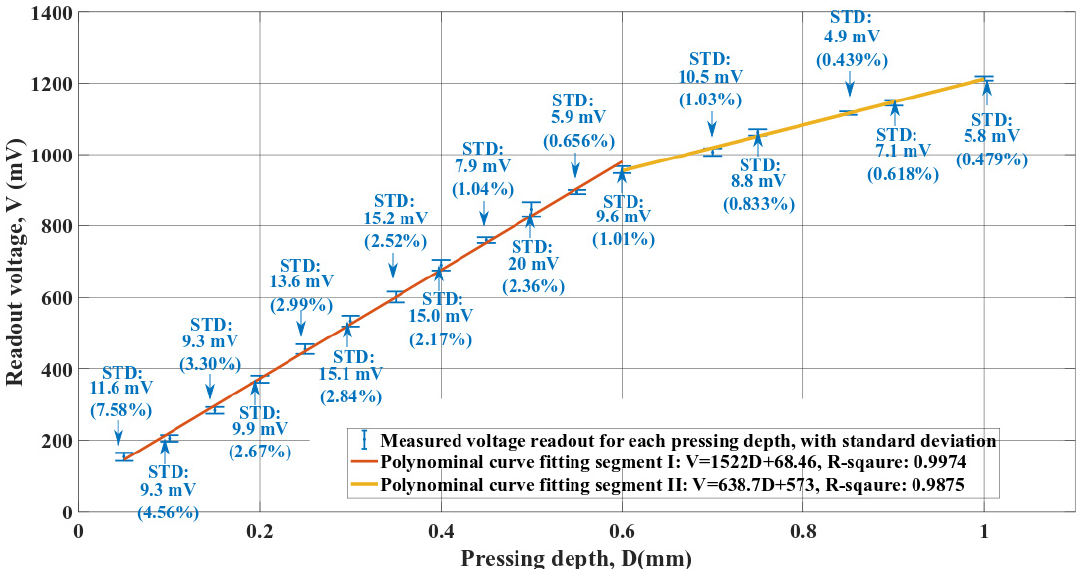
Figure 10. The piezoelectric tactile sensor readout output for input displacement from 50 μ m to 1000 μ m, with an increment step size of 50 μ m.